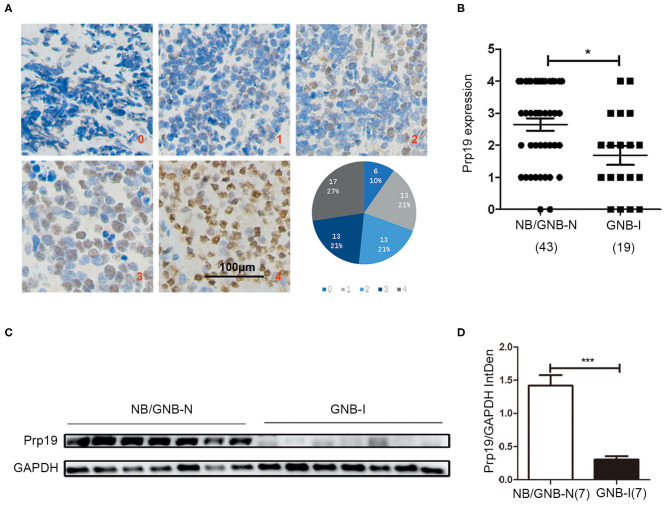
Expression and roles of Prp19 in neuroblastoma. (A) Representative images of different levels (0–4) of IHC staining of Prp19 and the proportions of five levels. Scale bar: 100 μm. (B) Prp19 expression between NB/GNB-N and GNB-I in TMA. The data were analyzed by Mann-Whitney U-test (n = 62). (C,D) Proteins of 7 NB/GNB-N and 7 GNB-I tumor tissue proteins extracted for immunoblotting to detect Prp19 expression, and Image J was used to quantify protein bands. The data in (D) were analyzed by Mann-Whitney U-test (n = 14). *p < 0.05 and ***p < 0.001.